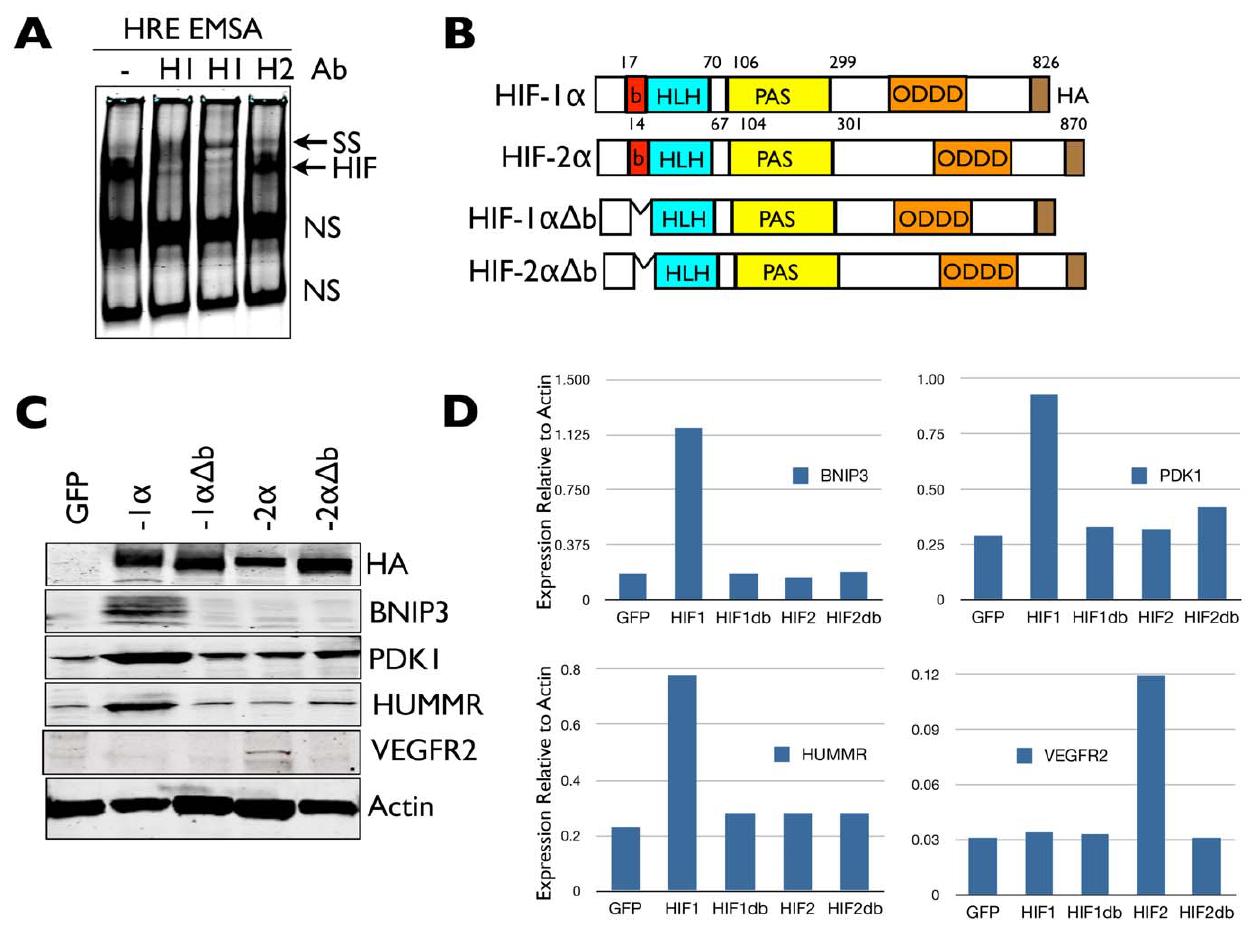
Figure 6. Canonical vs non-canonical HIF target gene-expression in TS cells. (A) Electrophoretic mobility shift assay (EMSA) of differentiated control TGC nuclear extracts with and without 2 different anti-HIF-1 a antibodies (H1) or a HIF-2 a antibody (H2) (‘‘supershift’’ SS, NS, non-specific complexes.) (B) Schematic representation of full-length HIF-1 a and HIF-2 a , as well as versions lacking their DNA binding basic (b) domains (HLH, Helix- loop-helix, PAS, Per-Arnt-Sim, ODDD, oxygen-dependent degradation domain). (C) Immunoblot detection of stable HA-epitope tagged HIF-1 a , HIF- 1 aD b, HIF-2 a and HIF-2 aD b protein, as well as respective target gene protein products in Hif-1/2 a 2 / 2 TSCs. (D) Integrated densitometric quantification of HIF target gene protein products relative to Actin expression in each respective cell